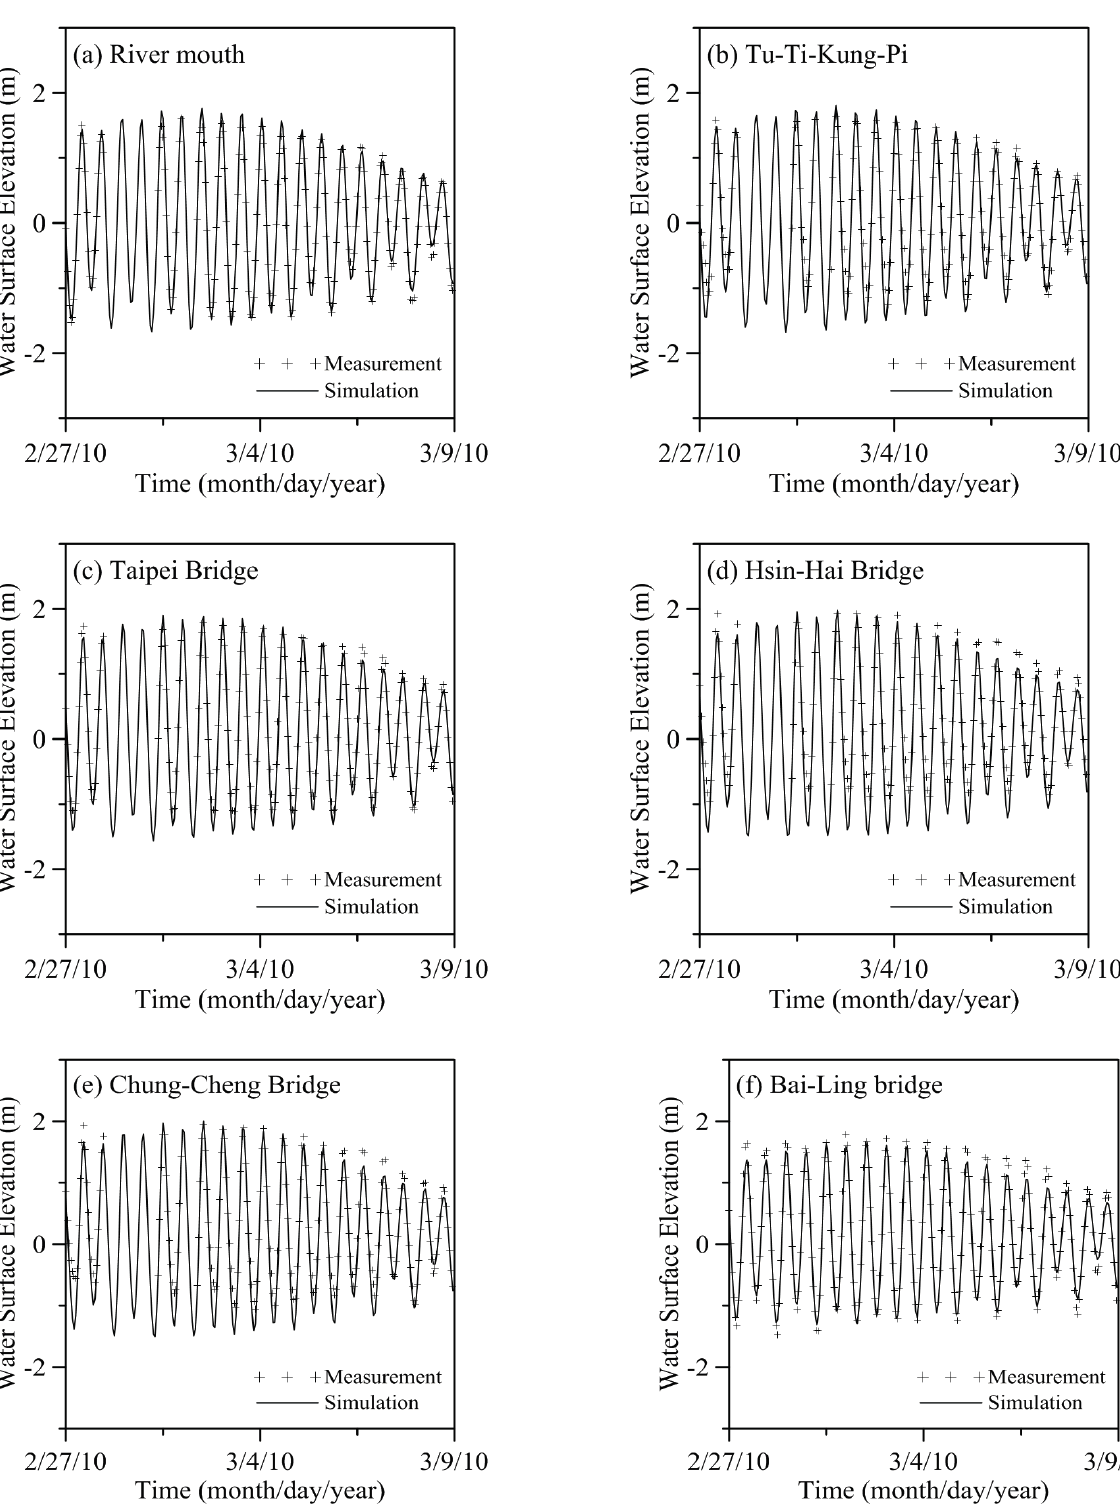
Figure 3. Comparison between measured and simulated water surface elevation during the period of 27 February to 8 March 2010, at the ( a ) Danshuei River mouth, ( b ) Tu-Ti-Kung-Pi, ( c ) Taipei Bridge, ( d ) Hsin-Hai Bridge, ( e ) Chung-Cheng Bridge, ( f ) Bai-Ling Bridge and ( g ) Ta-Chih